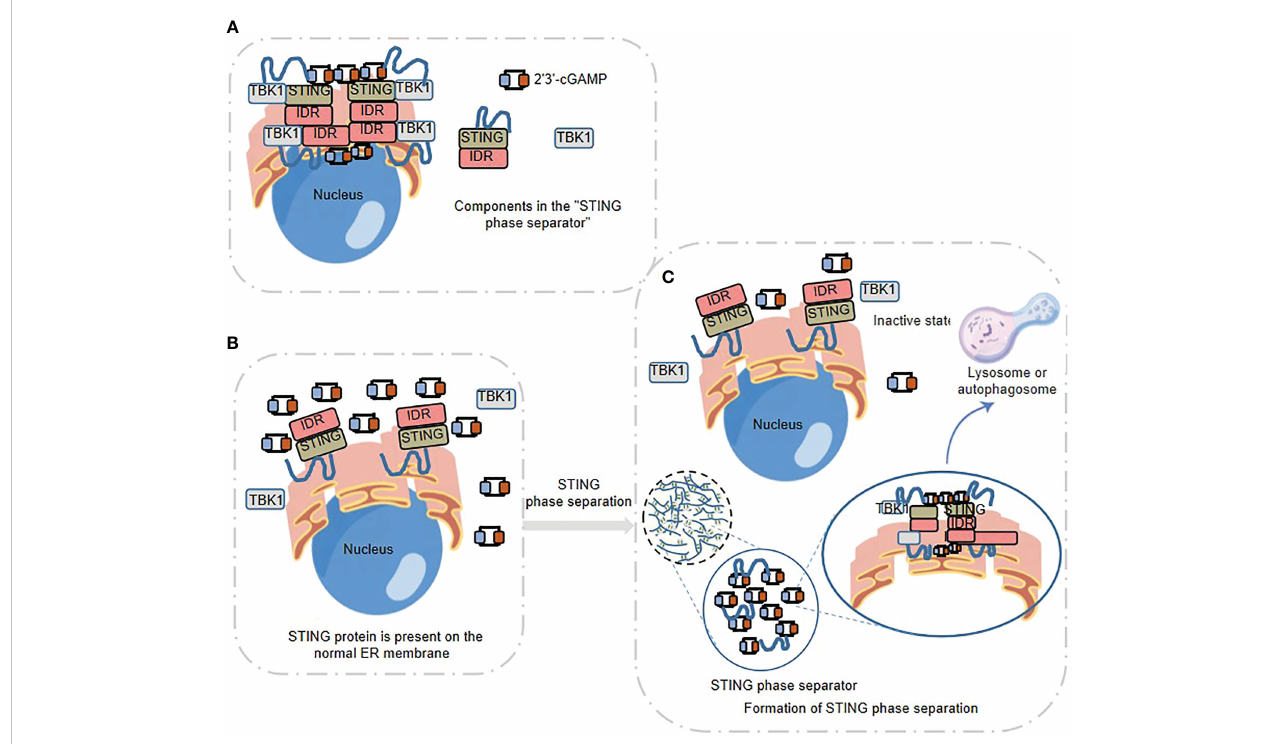
FIGURE 3 STING phase separator-mediated spatiotemporal regulation of innate immune response (A) STING Phase Separator. 2 ’ 3 ’ -cGAMP- STING -TBK1 can be aggregated to form the STING phase separator. (B) STING, 2 ’ 3 ’ -cGAMP and TBK1 are present on the normal ER membrane. (C) Formation of STING phase separation. The “ STING phase separator ” comparts the inactive STING-TBK1 (also including 2 ‘ 3 ’ -cGAMP) and prevents the over-activation of innate immunity, which fi nally can be broken down by lysosomes or